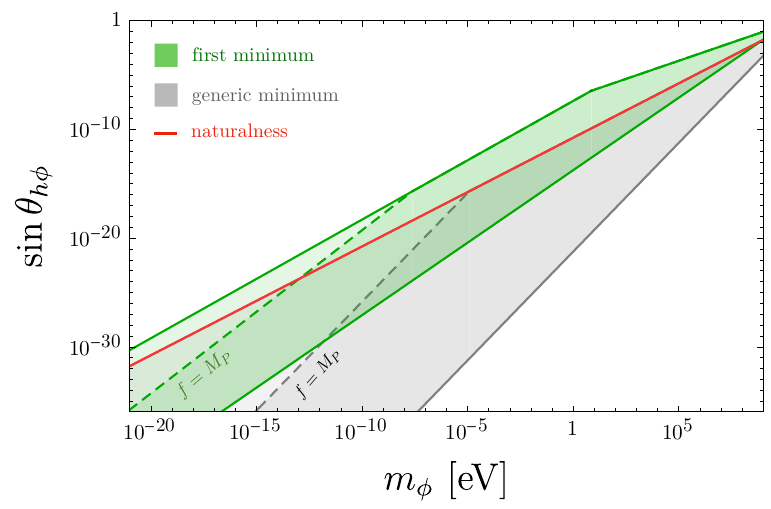
Figure 3 . Relaxion-Higgs mixing angle as a function of the relaxion mass. The green band corresponds to the (cid:12)rst minimum, the gray band to the generic minimum, and the red line is the naturalness bound of eq. (4.4). The regions above the dashed line correspond to super-Planckian relaxion decay